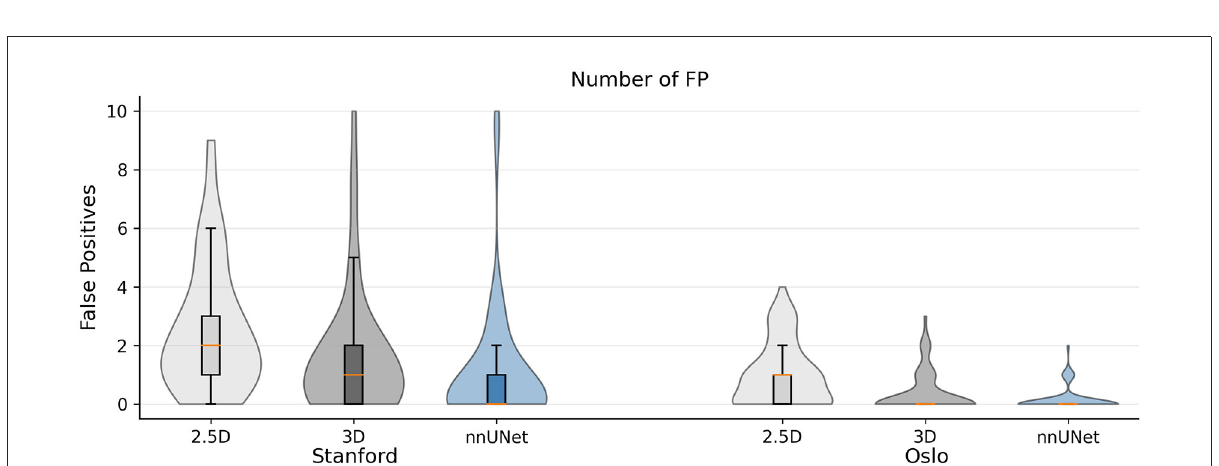
FIGURE5 Violin plot of the number of false positives per patient for the Stanford and OUH cohorts for the 2.5D, 3D, and nnU-Net. Patients with more than 10 false positives were excluded to improve readability. This accounts to five patients in the Stanford cohort and zero patients in the OUH cohort. The median number of false positives were either 2, 1, or 0 in the Stanford cohort and 1 or 0 in the OUH